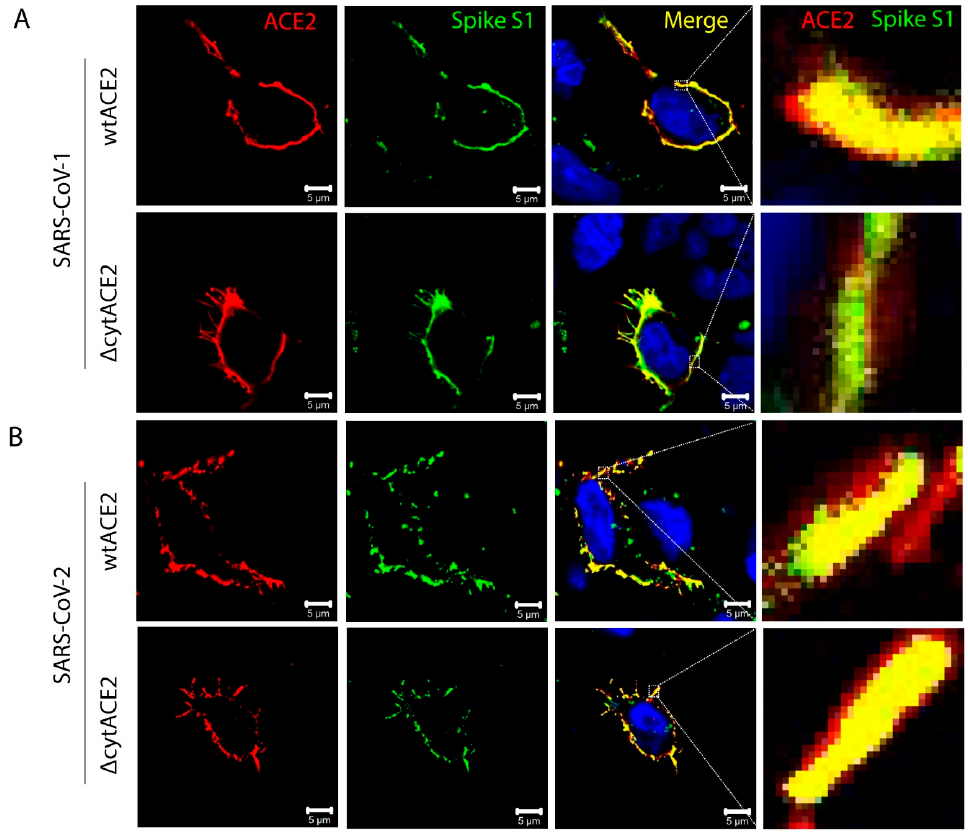
Figure 3. Colocalization of SARS-CoV spike S1-Fc proteins with wtACE2 and ∆ cytACE2. ( A ) Wildtype and mutant plasmid constructs were transfected independently in BHK21 cells and 24 h post transfection, cells were incubated with spike S1-Fc proteins (5 μ g/mL) of (A) SARS-CoV-1 and ( B ) SARS-CoV-2 at 4 ° C for 1 h. Spike S1-Fc proteins were stained with FITC-labeled anti-human IgG-Fc (green) and ACE2 using goat anti-ACE2 antibody followed by Alexa Fluor 594-conjugated secondary antibody (red). Nuclei were stained with DAPI (blue). Colocalization of ACE2 and spike proteins is shown as merged panel in yellow.